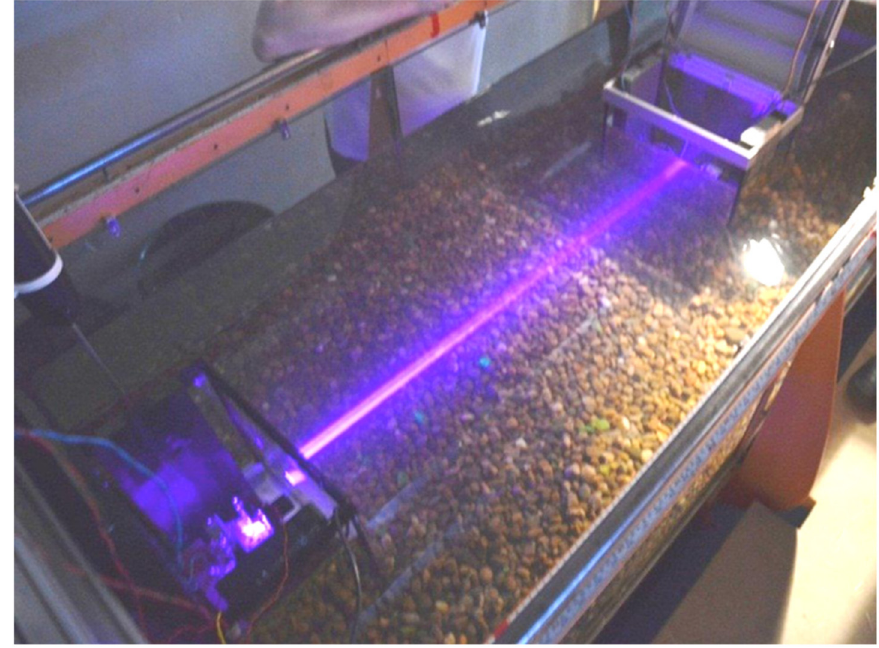
Figure 4. Collimated laser fired underwater from node to node in harbor-type water over a ~1 m distance.